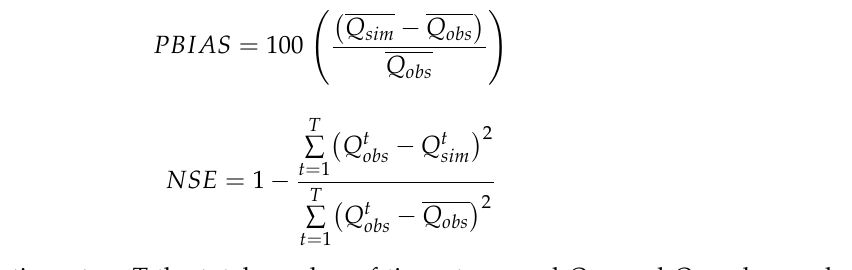
Figure 5. Daily synthetic rainfall (P Case1 ~P Case6 ) and calculated discharges simulated by HYPE COR and HYPE UA by using each SR (HYPE COR1 ~HYPE COR6 , HYPE UA1 ~HYPE UA6 ). Details of SRs were described in Section 2.3.